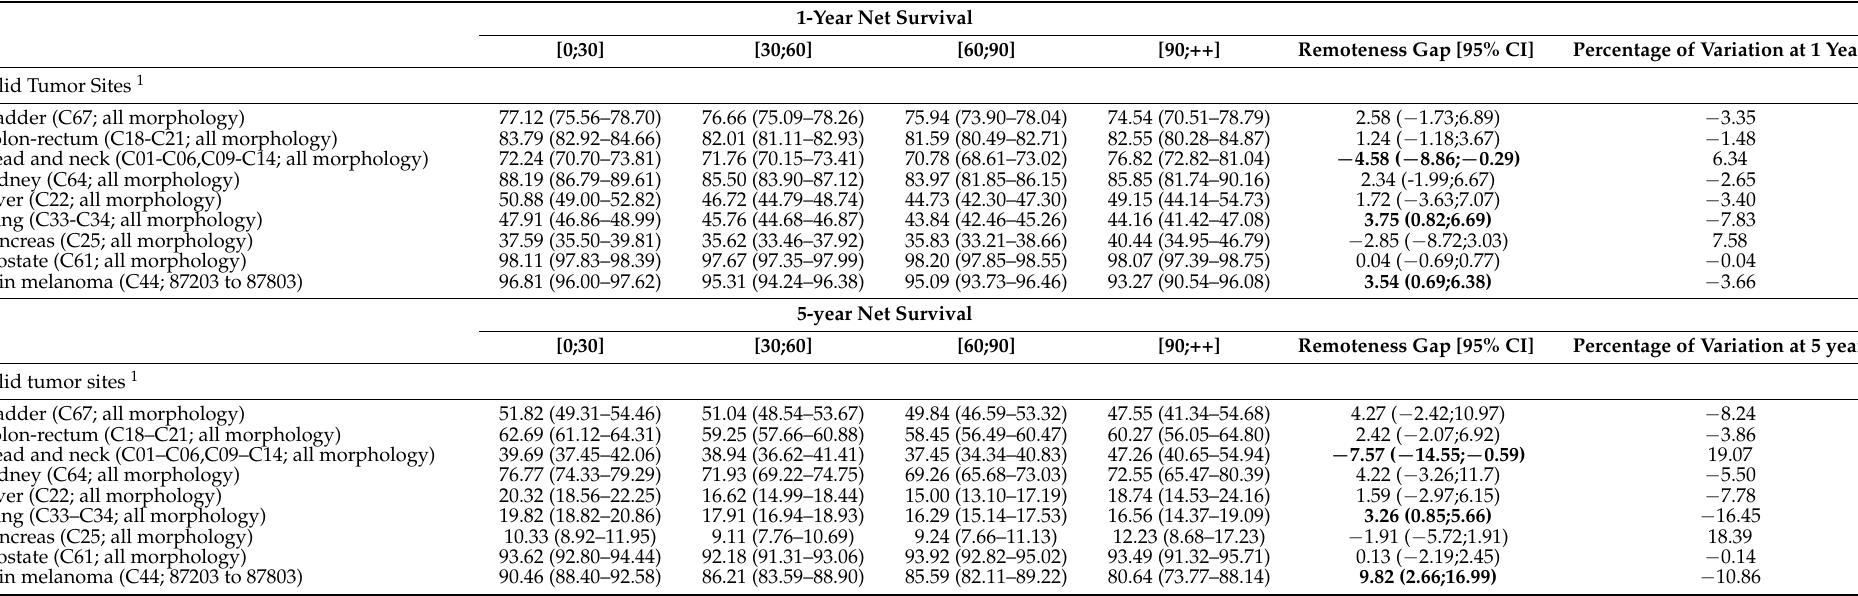
Table 2. One and five-year net survival probabilities and 95% confidence intervals and remoteness gap (RGap), by cancer site, in